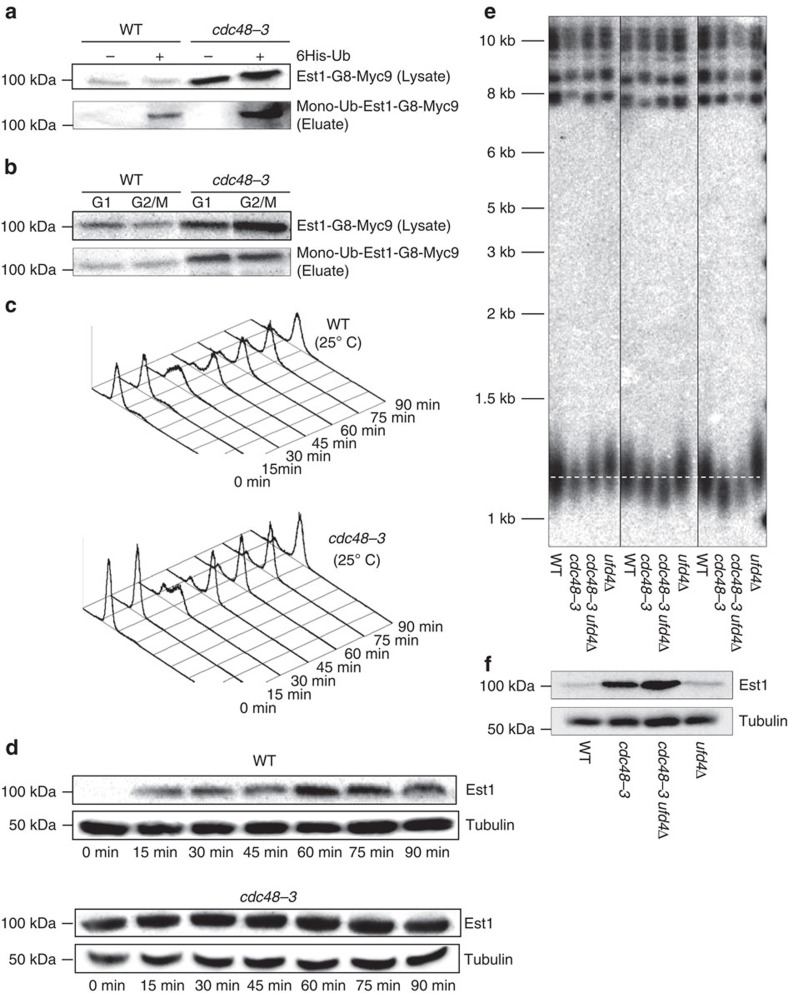
Ubiquitination of Est1 is increased and cell cycle-regulated abundance of Est1 is lost in cdc48-3 cells.(a) WT and cdc48-3 cells with Est1-G8-Myc9 were transformed with a plasmid encoding 6His-ubiquitin (‘+', 6His-Ub induction). In both the lysate and eluate, there was 10X more extract from WT cells than from cdc48-3 cells. Est1 was detected in both strains using anti-Myc western blotting in whole-cell lysates and after elution from Ni-NTA agarose, which purifies ubiquitinated proteins. See Supplementary Fig. 6A for full lane view of these data. (b) Samples were arrested in late G1 phase with α-factor (G1) and in G2/M phase with nocodazole (G2/M) and Est1 ubiquitination was detected using western analysis. See Supplementary Fig. 6C for full lane view of these data. (c) FACS profiles of WT (top) and cdc48-3 (bottom) cells grown at 25 °C. Cells were arrested in late G1 phase with α-factor (0 min time point), removed from α-factor and allowed to proceed synchronously through the cell cycle. Samples were removed for FACS and western analysis (d) at the indicated time points with anti-Myc. The same membrane was probed with anti-α tubulin as a loading control. See Supplementary Fig. 6E for full lane view of these data. (e) Southern blot analysis of DNA from three independent colonies of cdc48-3, cdc48-3 ufd4Δ, ufd4Δ cells and their respective (WT) isogenic controls were digested with XhoI and analysed by Southern blotting. (f) Proteins were prepared from α-factor-arrested WT, cdc48-3, cdc48-3 ufd4Δ and ufd4Δ cells grown at 25 °C (permissive temperature) and subjected to SDS–PAGE and western analysis of Est1 with mouse anti-Myc antibodies (Clontech) See Supplementary Fig. 6D for full lane view of these data.